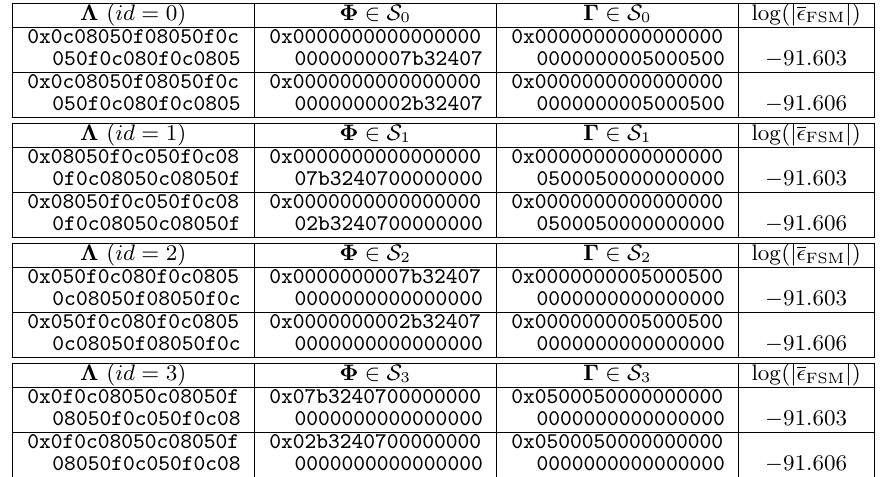
Table 2: The best linear masks ( Φ , Γ , Λ ) for the bitwise linear approximation of the FSM of SNOW-V (cid:1) 32 , (cid:1)